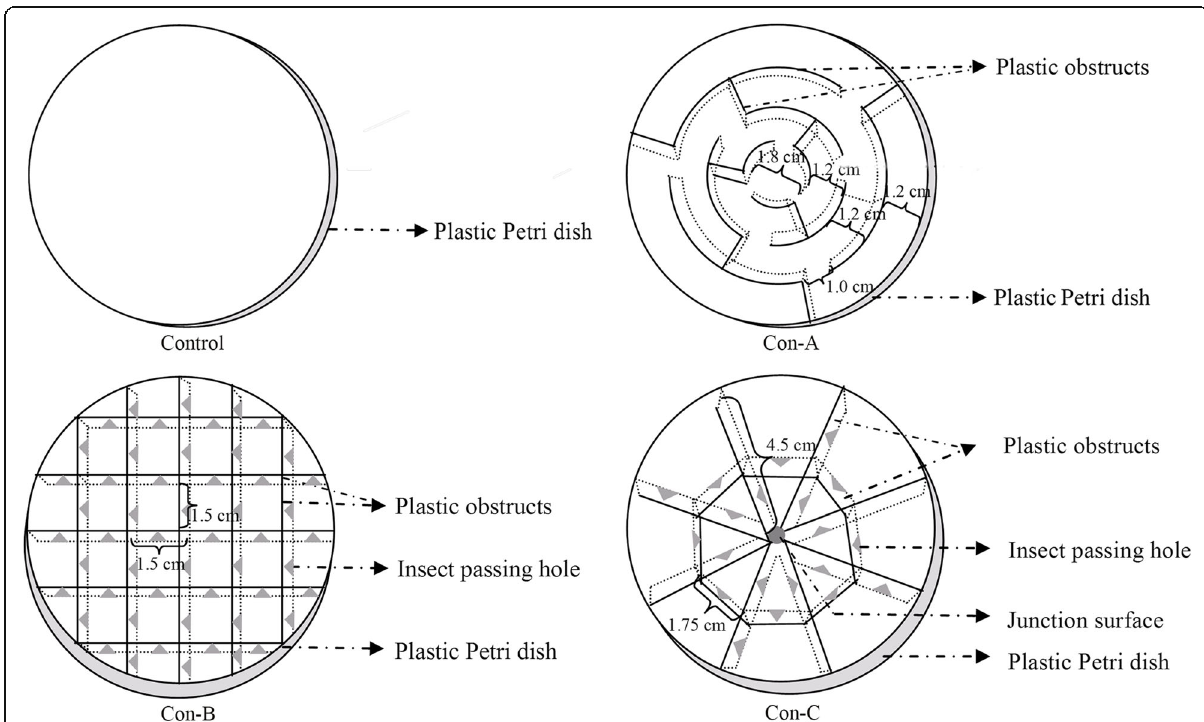
Fig. 1 The schematic diagrams of obstructs and rearing units. The units consist of a plastic Petri dish and one of three obstructs with different patterns Con-A, Con-B, and Con-C. The obstructs were made from pieces of transparent plastic strip (polyvinyl chloride, 1.5 cm in width, 8.9 cm in length, and 0.05 cm thickness). Control: the empty Petri dish (polystyrene, 9 cm in diameter, 1.5 cm high). Con-A, Con-B, and Con-C: the units of Petri dish equipped with Con-A, Con-B, and Con-C obstructs,